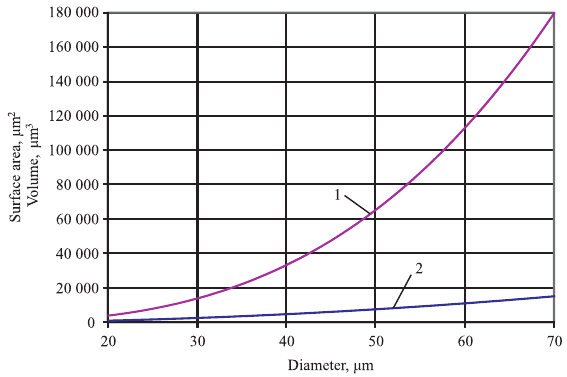
Figure 5. Dependence of the volume of cavities in the plant leaf ventilation system (curve 1) and the surface area of its walls (curve 2), on the channel diameter